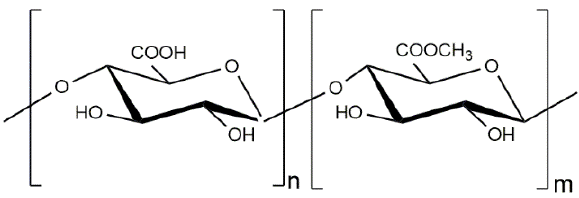
Figure 5. Chemical structure of partially acetylated polygalacturonic acid in pectin.